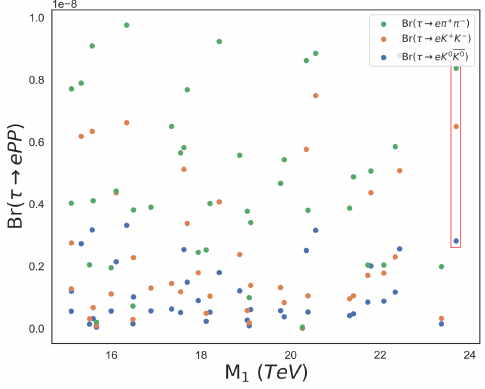
Figure 14 . Scatter plot M 1 vs. Br( τ → ePP ) considering Majorana neutrinos.